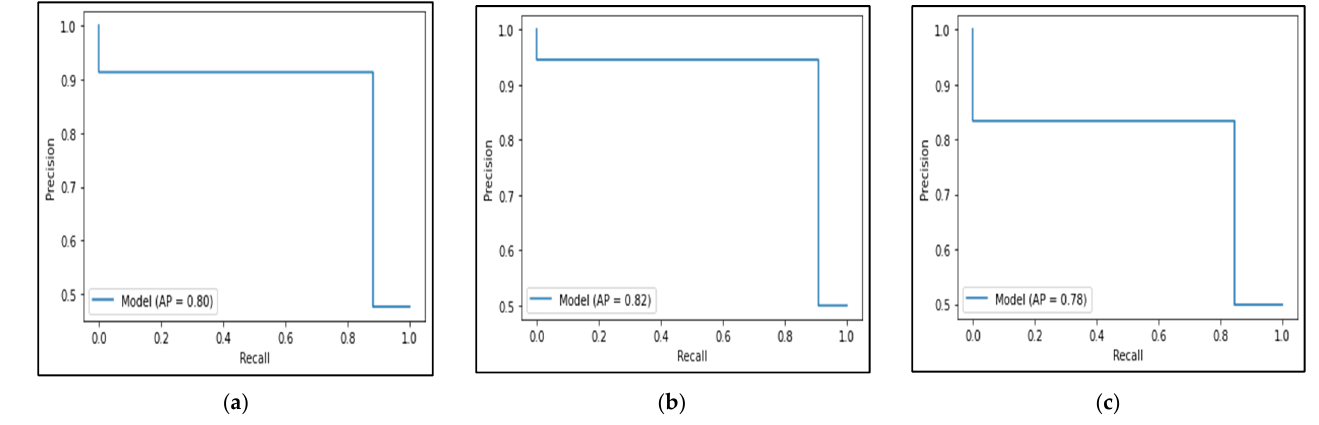
Figure 16. Average precision (AP) of ( a ) SARC. ( b ) Twitter. ( c ) Headlines datasets.